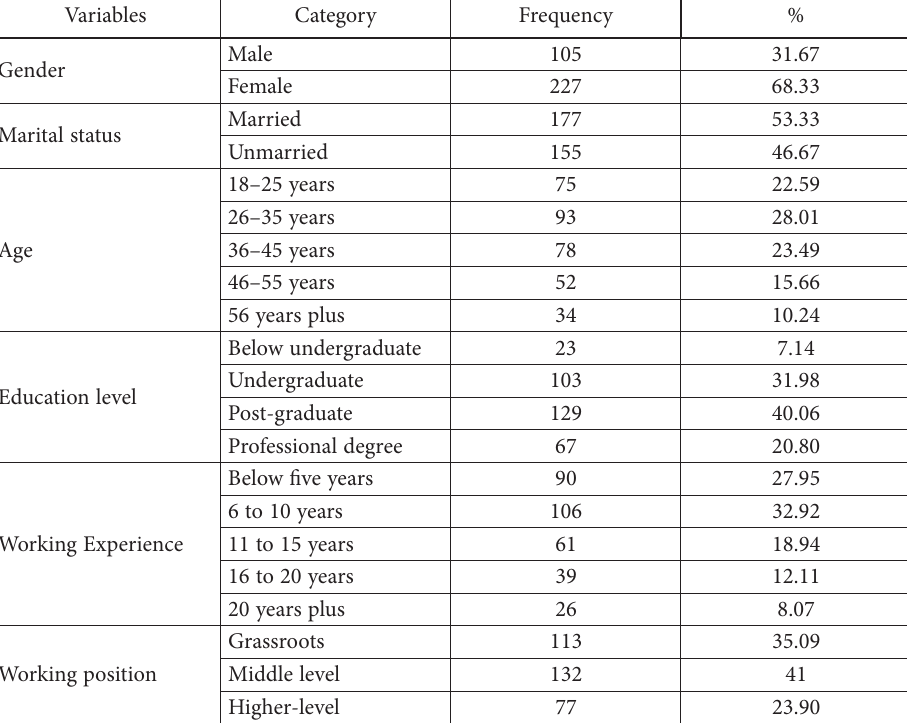
Table 1. Demographic profile of the respondents (source: data collected from the survey) Variables